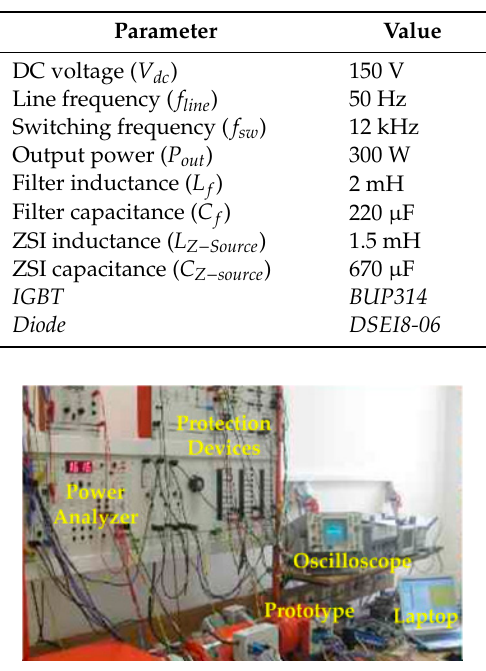
Table 5. Prototype Main Specifications.